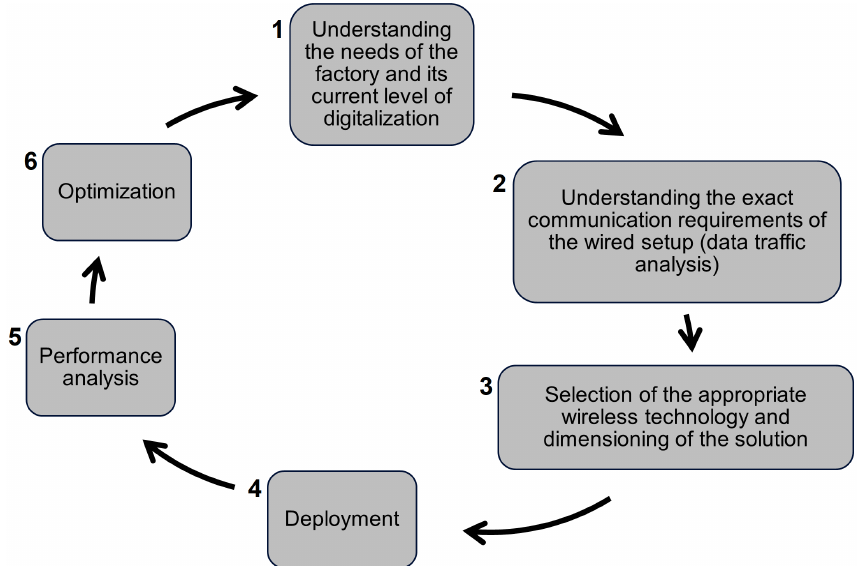
Figure 1. Flow diagram illustrating the different steps of the proposed industrial automation opera- tional